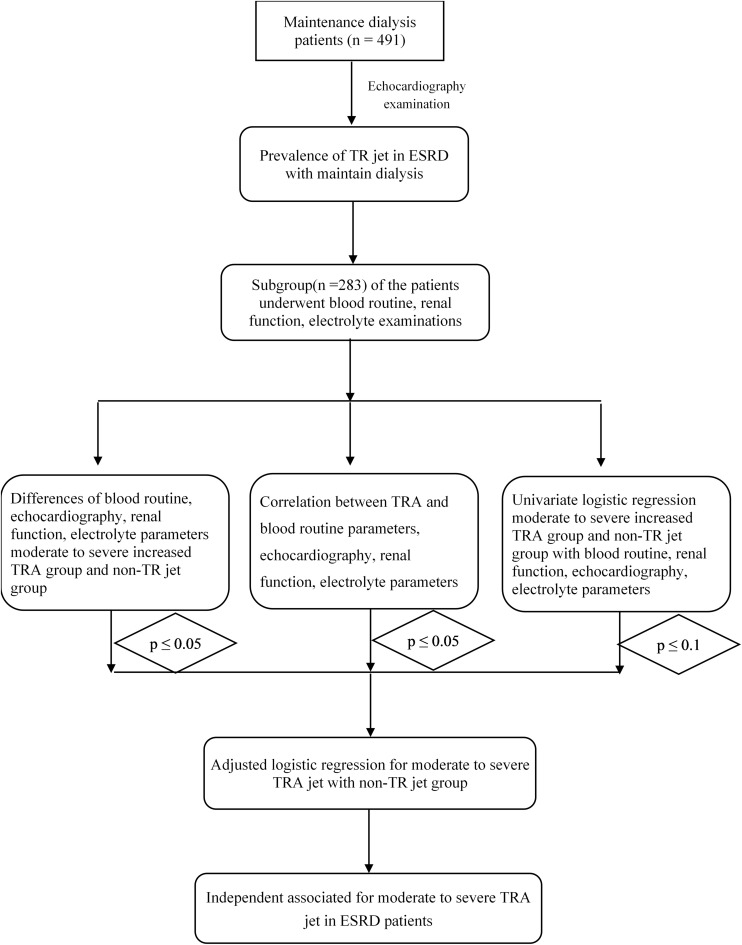
The flow chart of this study.